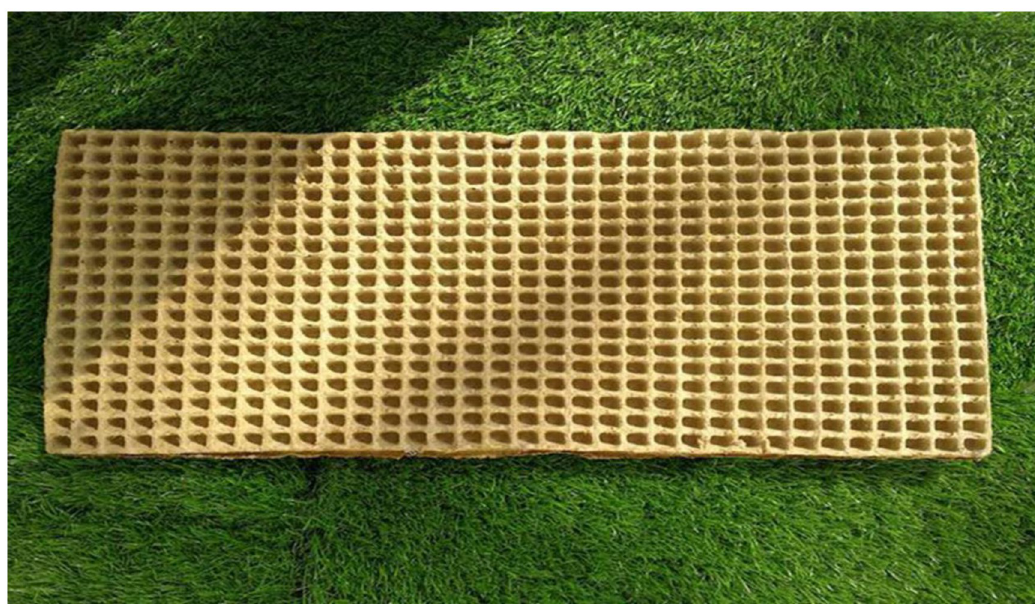
Fig 11. Picture of rice straw bowl